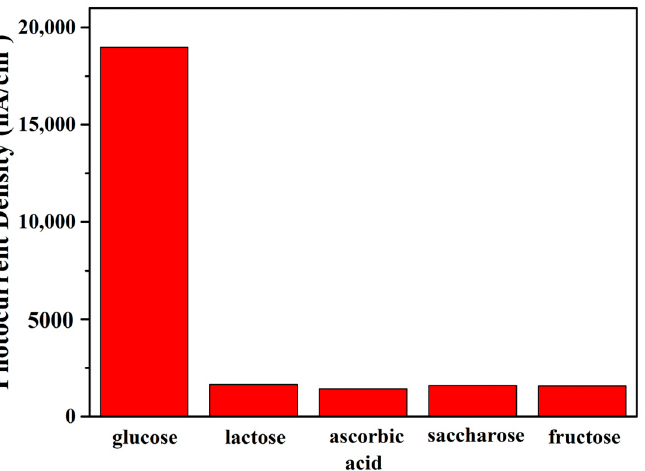
Figure 8. Comparison of photocurrent sizes of a 0.5 wt.% Au/TiO 2 NT electrode in various solutions.